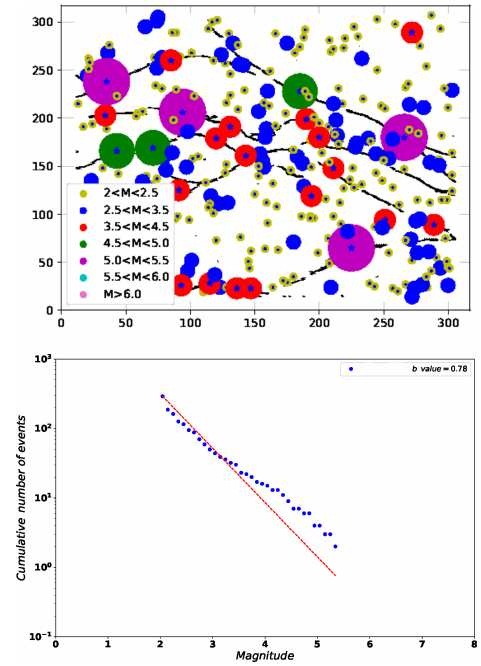
Figure 16. (a) Example of the spatial distribution of simulated events for a particular FBM realization with P = 0, π frac = 0 . 95, and N = 300. Circular areas depict the equivalent magnitude–area relation computed from Eq. (6). Star markers indicate the epicenter of each simulated earthquake. (b) Gutenberg–Richter fit of